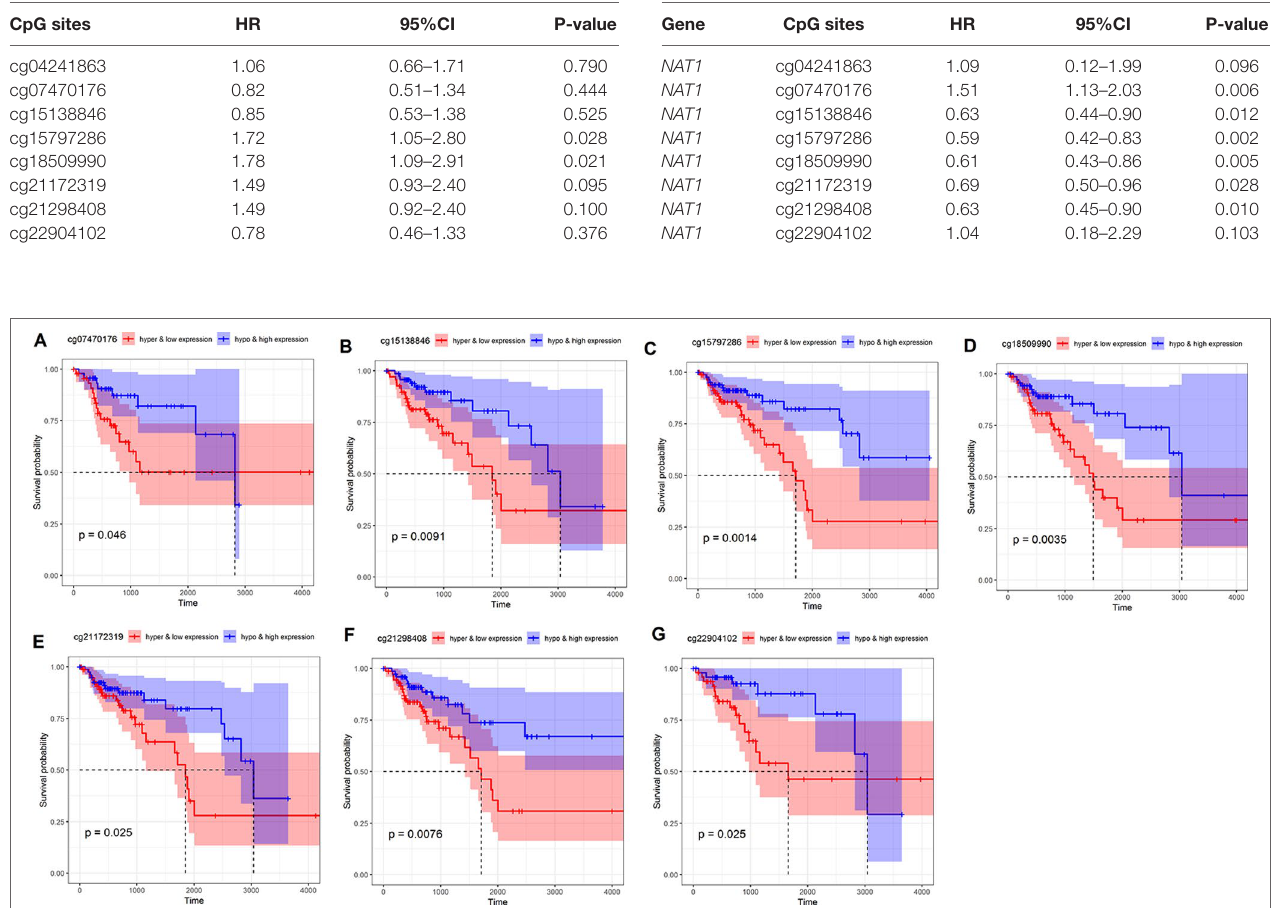
FIGURe 4 | Kaplan–Meier curve of combination of N - acetyltransferase 1 ( NAT1 ) mRNA with CpG sites in COAD. ( A ) NAT1 mRNA with cg07470176; (B) NAT1 mRNA with cg15138846; (C) NAT1 mRNA with cg15797286; (D) NAT1 mRNA with cg18509990; (e) NAT1 mRNA with cg21172319; (F) NAT1 mRNA with cg21298408; (G) NAT1 mRNA with cg22904102.